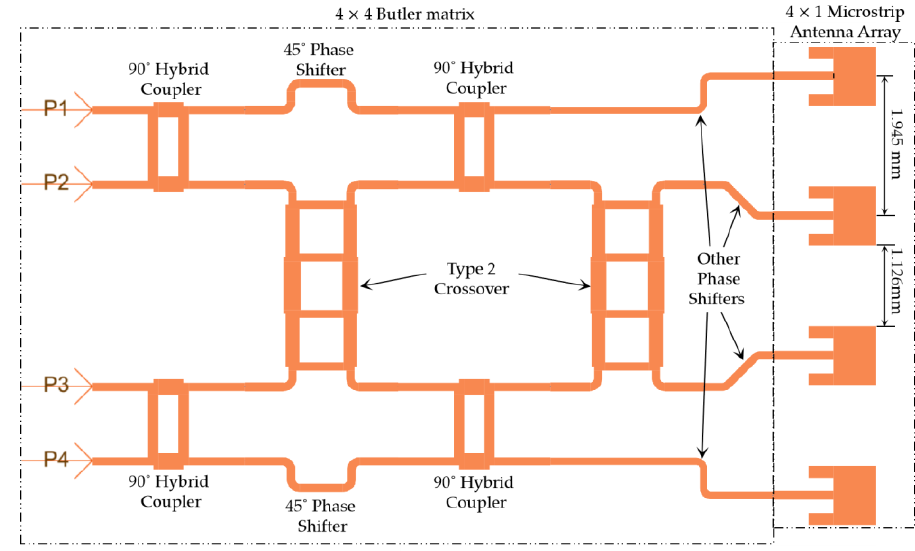
Figure 20. A 4 × 4 Butler matrix with a microstrip antenna array of four elements in ADS.